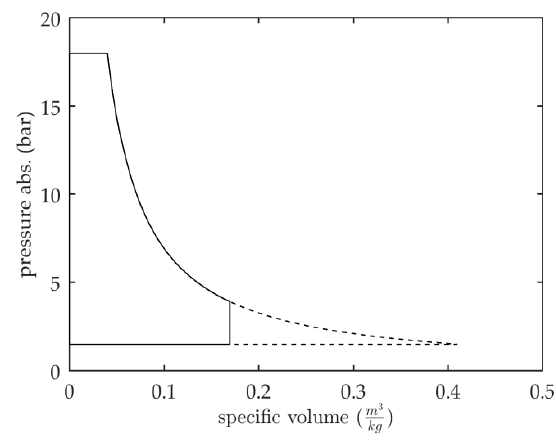
Figure 6. Ideal inner expansion with under expansion losses, ethanol real gas data [21,22]; compare